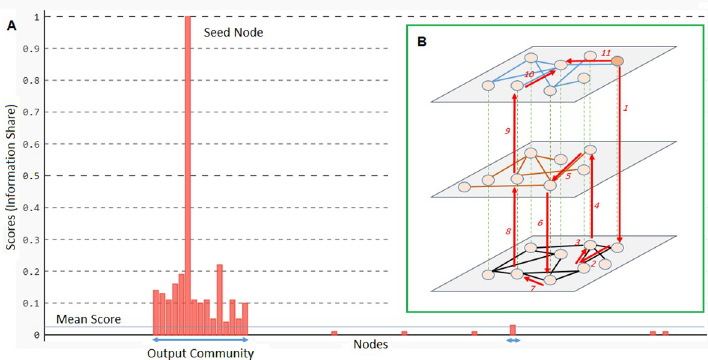
Fig 2. Demo of community detection procedure. (A) Extraction of a community using the information share (z- score) extent of vertices. (B) Random walk with random restart process from a seed node in a typical multilayer